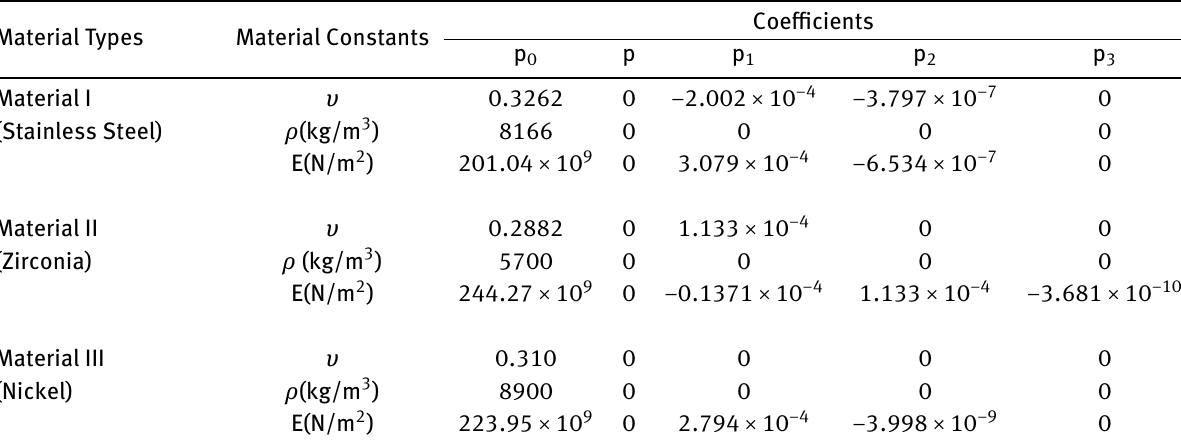
Table 1: Material properties of FG materials for circular cylindrical shell